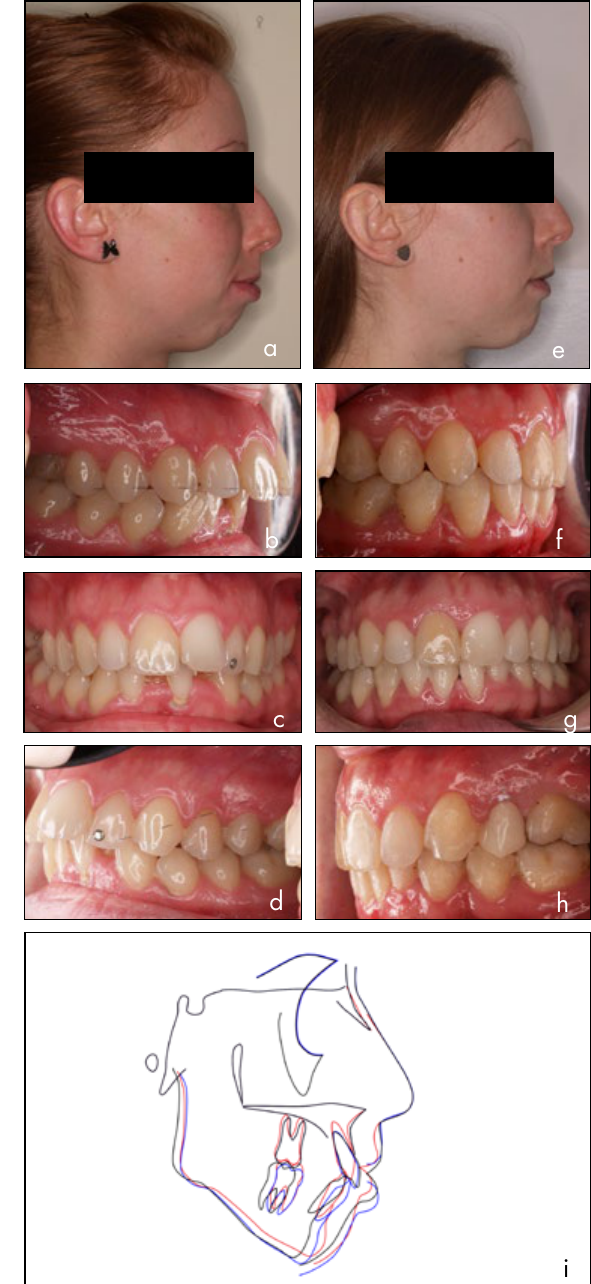
Figure 5. (a–d) A twenty-seven-year-old woman with a severe skeletal Class II relationship, an increased overjet, a posteriorly positioned mandible and severe lower crowding. (e–h) Treatment comprised a mandibular advancement of 4 mm, intrusion of the upper posterior teeth using TADs as anchorage and the extraction of three premolars and one compromised molar. Following treatment a significant improvement of the profile can be appreciated. (i) Tracings representing T0, T1 and T2. The intrusion of the maxillary teeth led to an anterior rotation of the mandible, which brought pogonion further